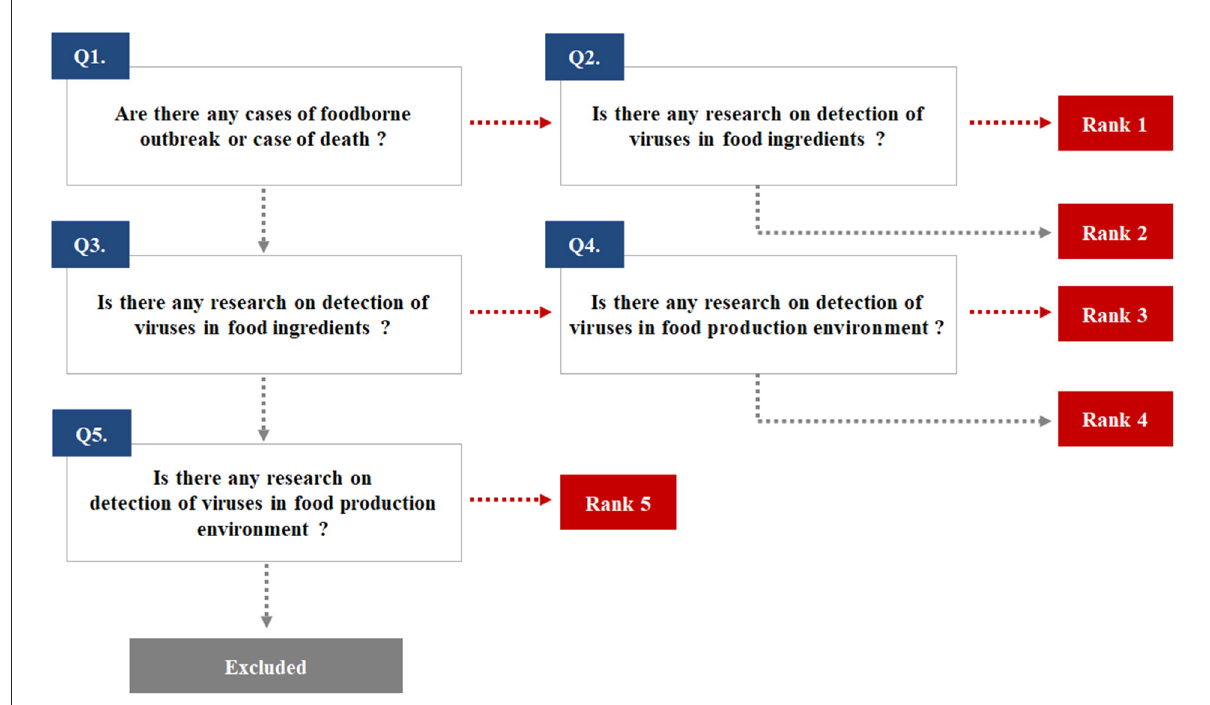
FIGURE1 The ranking used to select emerging infectious viruses transmitted through the fecal-oral route.